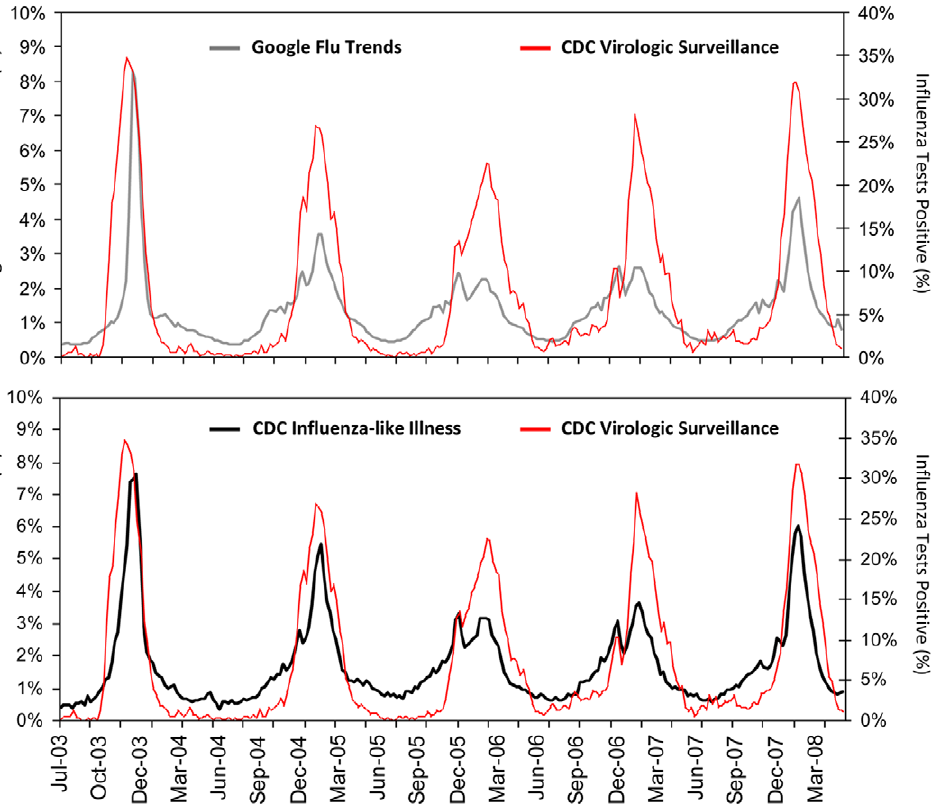
Figure 1. United States Influenza Surveillance by Google Flu Trends 1 , CDC Influenza-like Illness Surveillance 2 , and CDC Influenza Virologic Surveillance 3 , June 29, 2003 through May 31, 2008 4 . 1 Google Flu Trends estimates the percentage of persons seeking health care for the non-specific complaint of influenza-like illness (ILI) based on internet key word searches. 2 CDC Influenza-like Illness Surveillance involves a network of health care providers who record the weekly proportion of patients seen with ILI. Google Flu Trends was created and validated using CDC ILI Surveillance data, explaining the similarity between the two curves. 3 CDC Influenza Virologic Surveillance consists of about 140 laboratories located throughout the United States that report the weekly total specimens tested and laboratory tests positive for influenza virus. This is the only US surveillance system that provides national and regional data of laboratory-confirmed influenza virus infection. 4 Because CDC surveillance is intensified from calendar week 40 through calendar week 20 of the subsequent year, we restricted our correlation analyses to this time period.